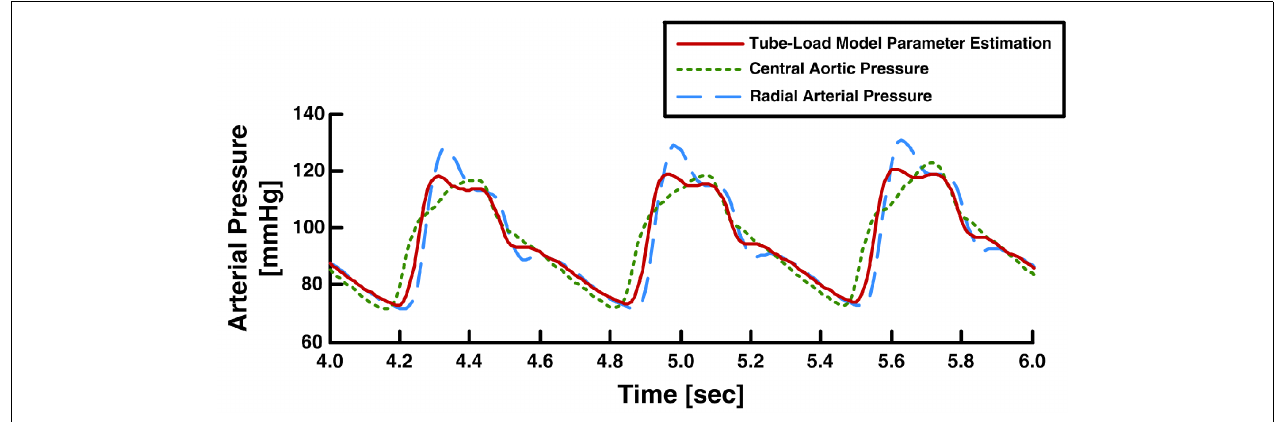
FIGURE 12 | Measured aortic and radial arterial pressure waveforms and aortic pressure waveform derived from the radial arterial pressure waveform. Adapted from Hahn et al.